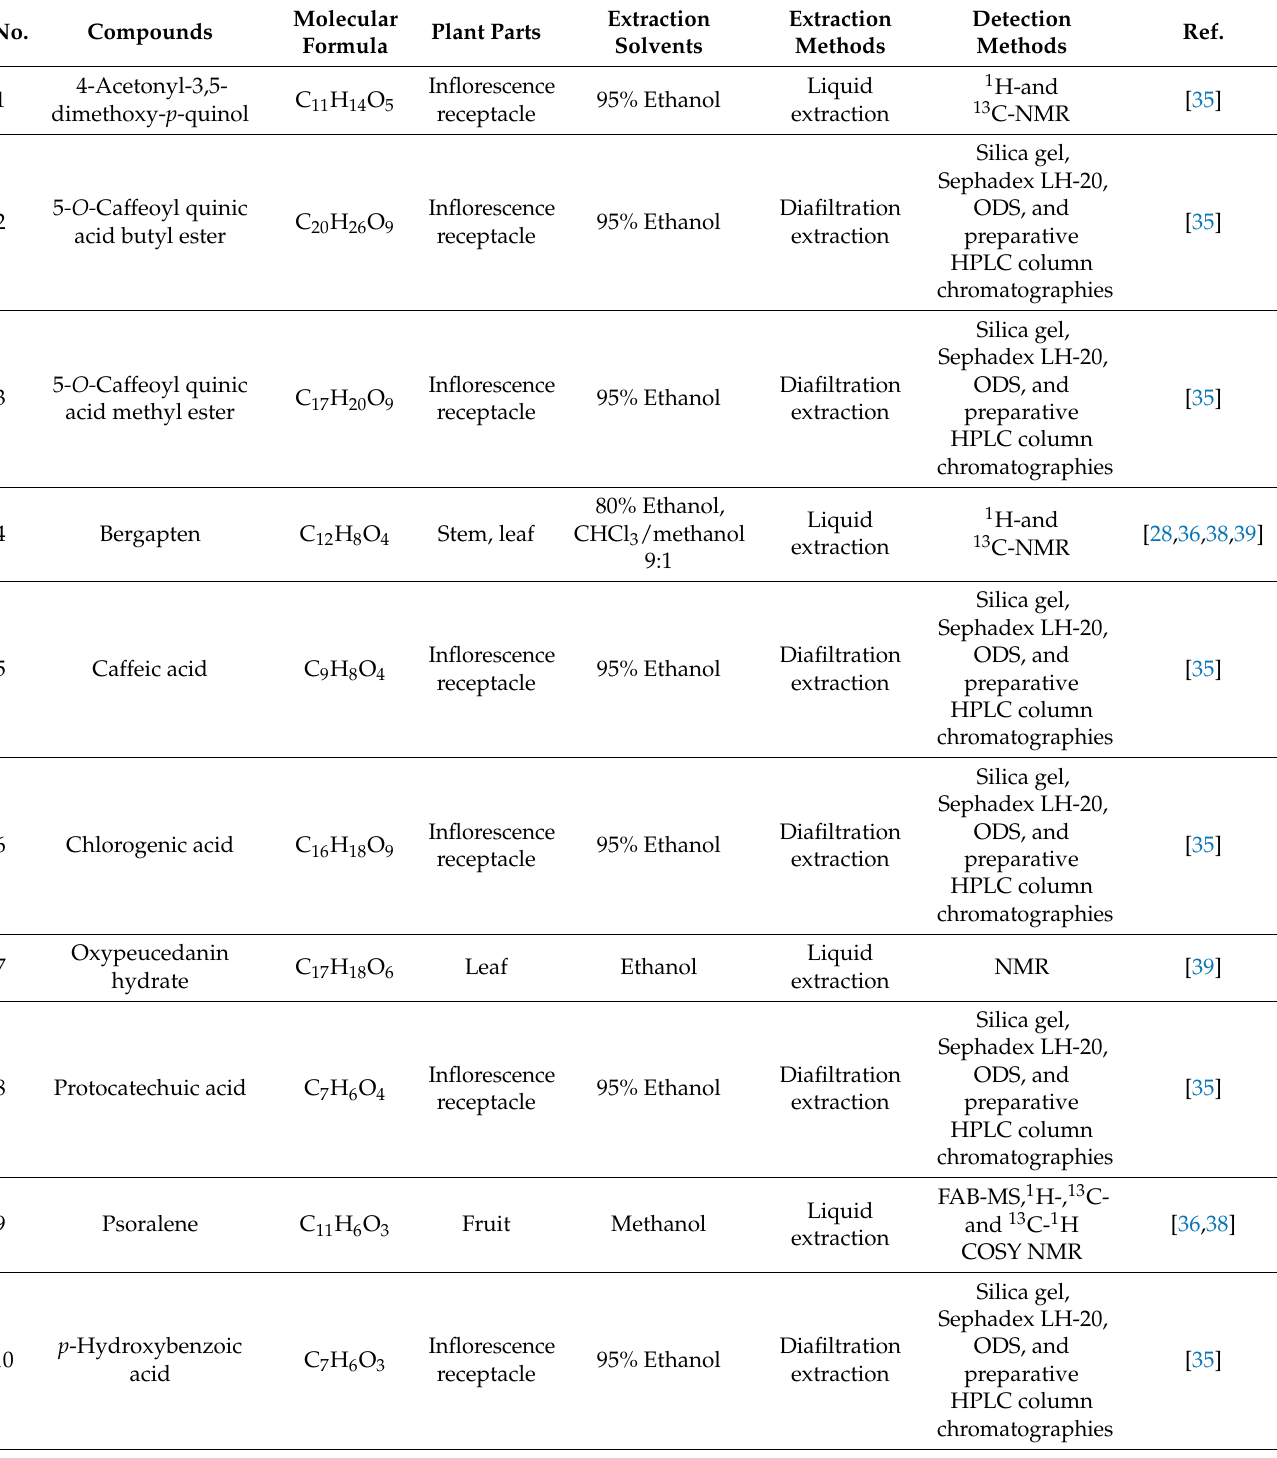
Table 2. Phenolic acids and their derivatives found in Ficus pumila